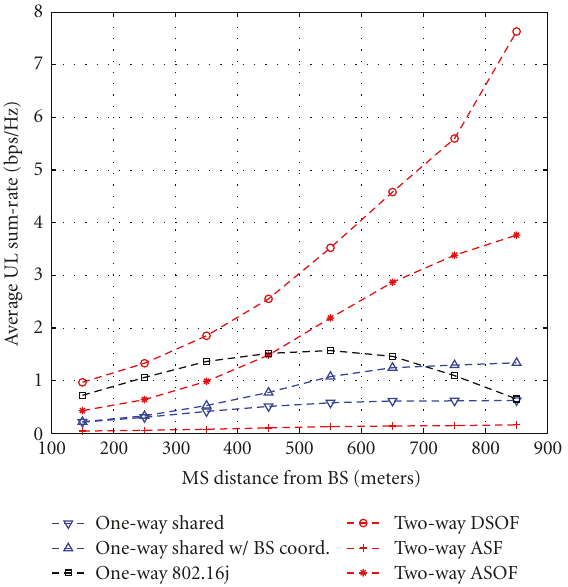
= (1 / 3)min { R DL } . DL 1 , R 3 DSOF